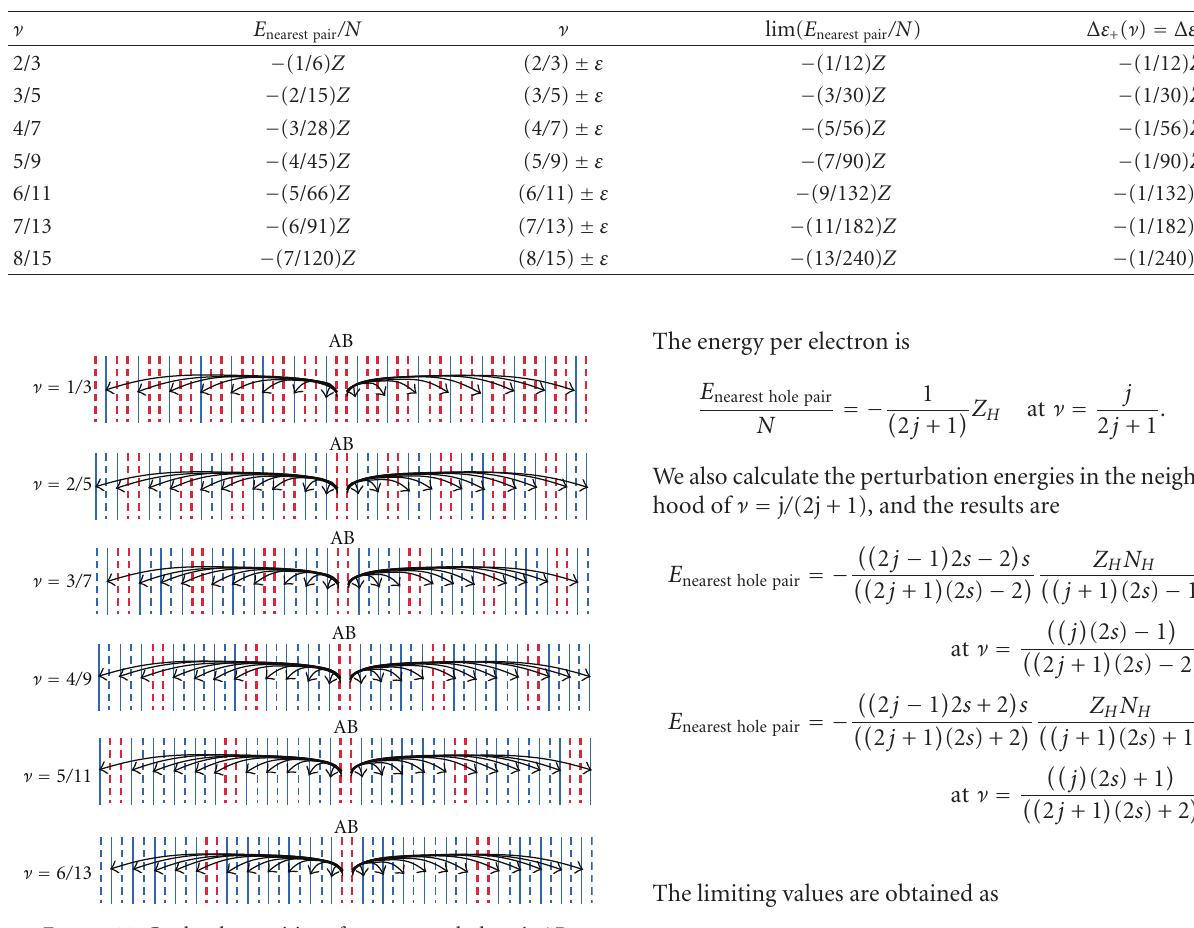
Table 1: Energy gaps of nearest electron pairs per electron at ν = j/ (2 j − 1).